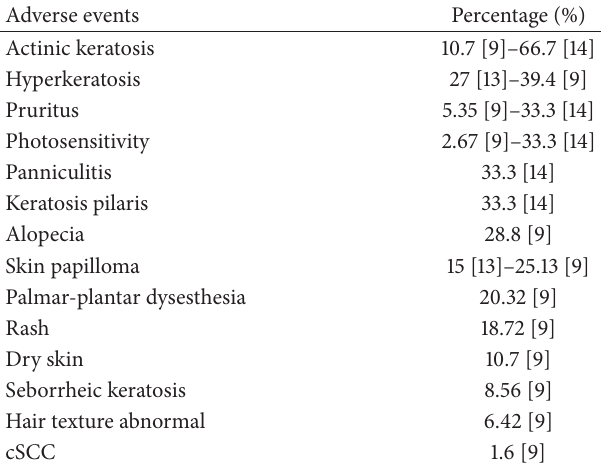
Table 2: Percentage of common ( > 5%) cutaneous adverse events with dabrafenib